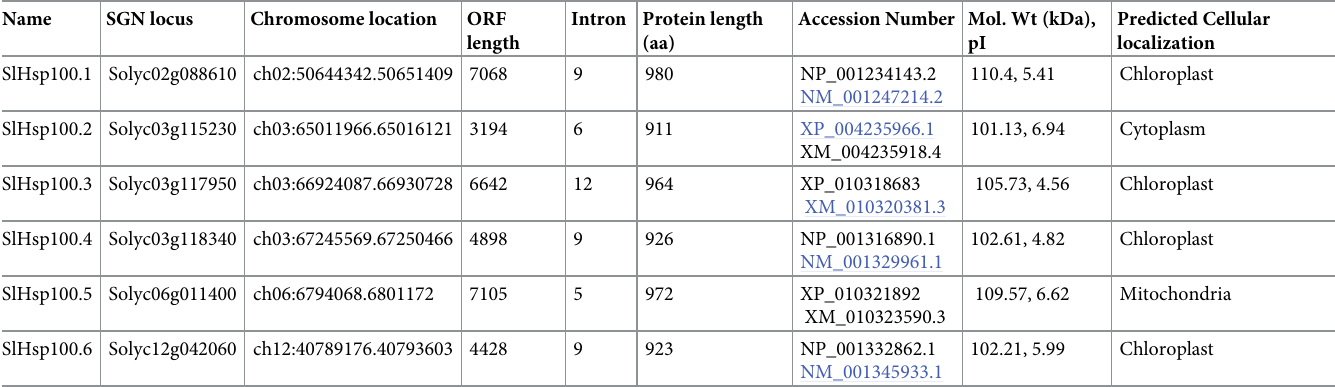
Table 1. Features of SlHsp100 genes in